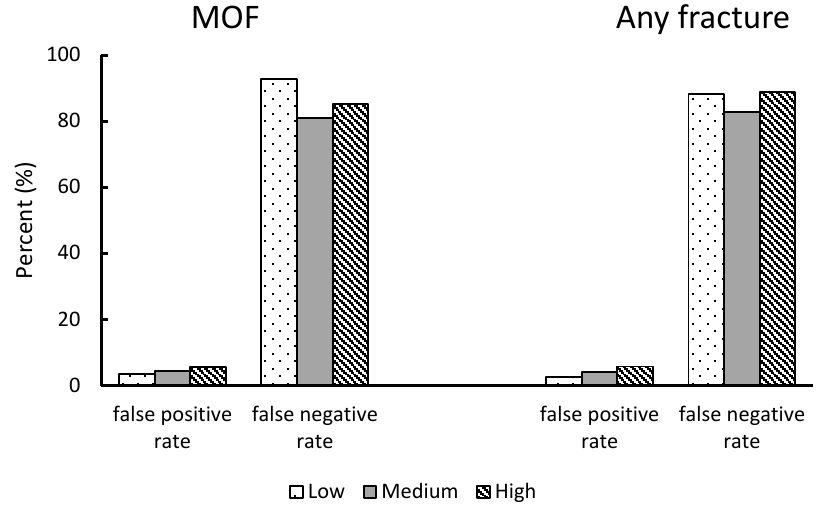
Figure 3. False-positive rate and false-negative rate for major osteoporotic fracture and any fracture in the analytic sample by polygenic score group.